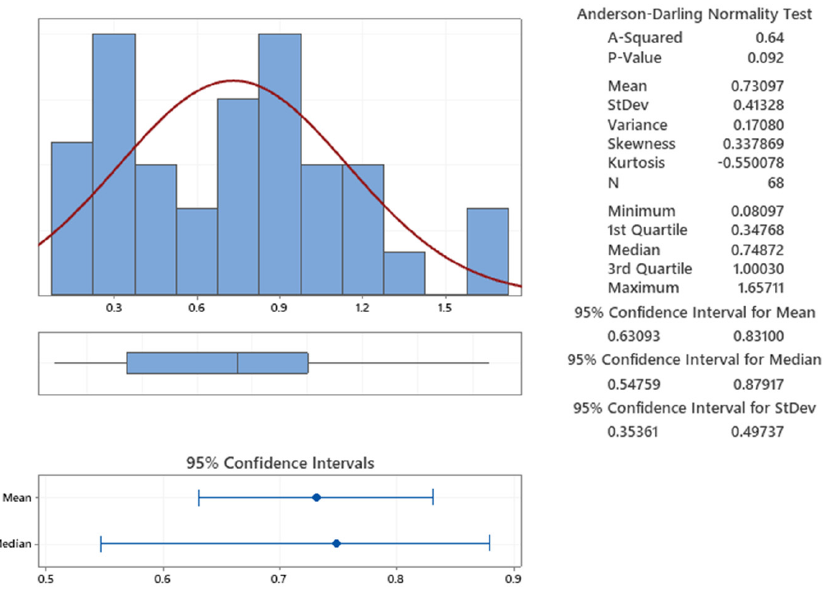
Figure 7. Trailer loading performance in the storage area.